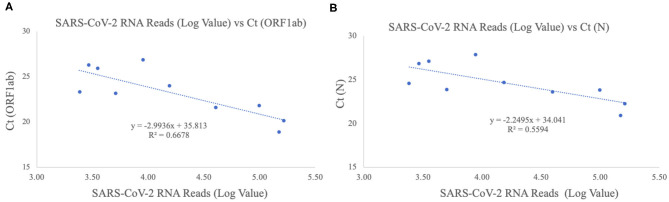
Correlation of Ct values and SARS-CoV-2 RNA reads. (A)
ORF1ab gene target. The X-axis plots the log value of the SARS-CoV-2 RNA reads while the Y-axis plots the Ct values for the ORF1ab gene for the 10 Shaoxing patients. (B)
N gene target. The X-axis plots the log value of the SARS-CoV-2 RNA reads while the Y-axis plots the Ct values for the N gene for the 10 Shaoxing patients.